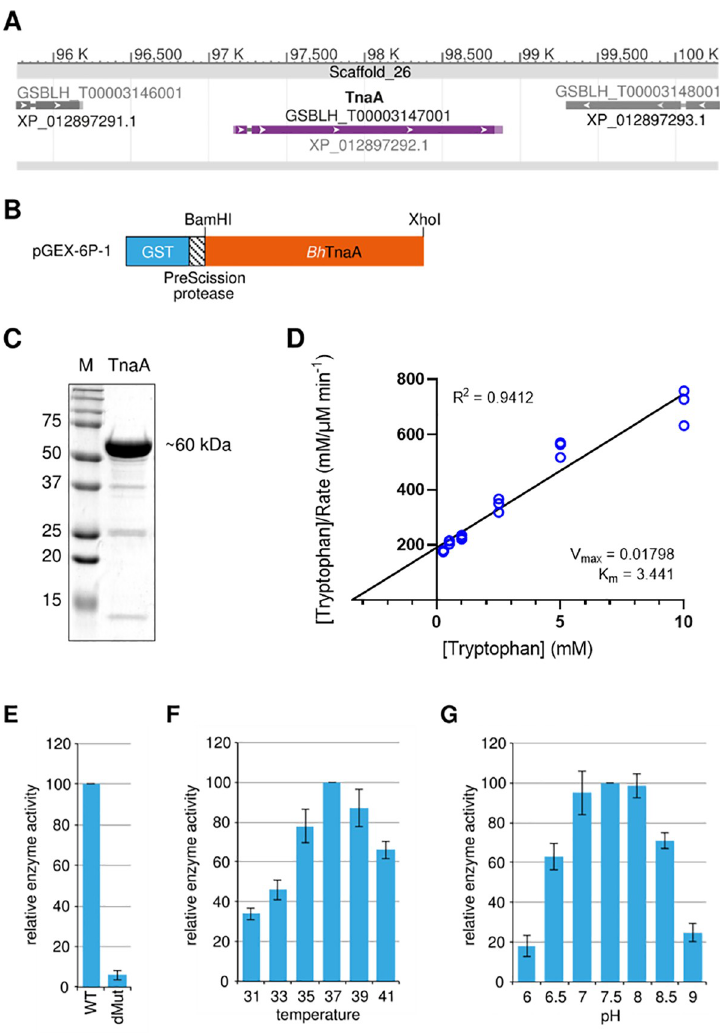
Fig 4. Bh TnaA functions ideally at human body temperature and pH. A and B) Simplified map of the Bh TnaA insert within the pGEX-6P-1 vector. Bh TnaA is tagged with GST, with a PreScission protease sequence for cleavage of the tag. C) Western blot of the purified and cleaved Bh TnaA isolate. Used to demonstrate validity of the protein purification process. The TnaA band is equivalent to the mathematically-derived expected size of the protein. D) Hanes- Woolf plot generated via supplementing purified Bh TnaA with increasing concentrations of tryptophan, and determining quantity of produced indole via absorbance (as in Fig 2C). V max is in units of μ M product generated min -1 . K m is in units of mM substrate. Curve calculated for the mean of the three data points shown at each tryptophan concentration. E) Effect of Bh TnaA inactivation (dMut) on indole production. Production calculated as rosindole layer absorbance post-tryptophan supplementation and 72 hrs incubation. F and G) Optimal temperature and pH for purified Bh TnaA activity. Experiment identical to Fig 3E with variation of either temperature during incubation, or pH of media. Error bars were calculated using Student’s